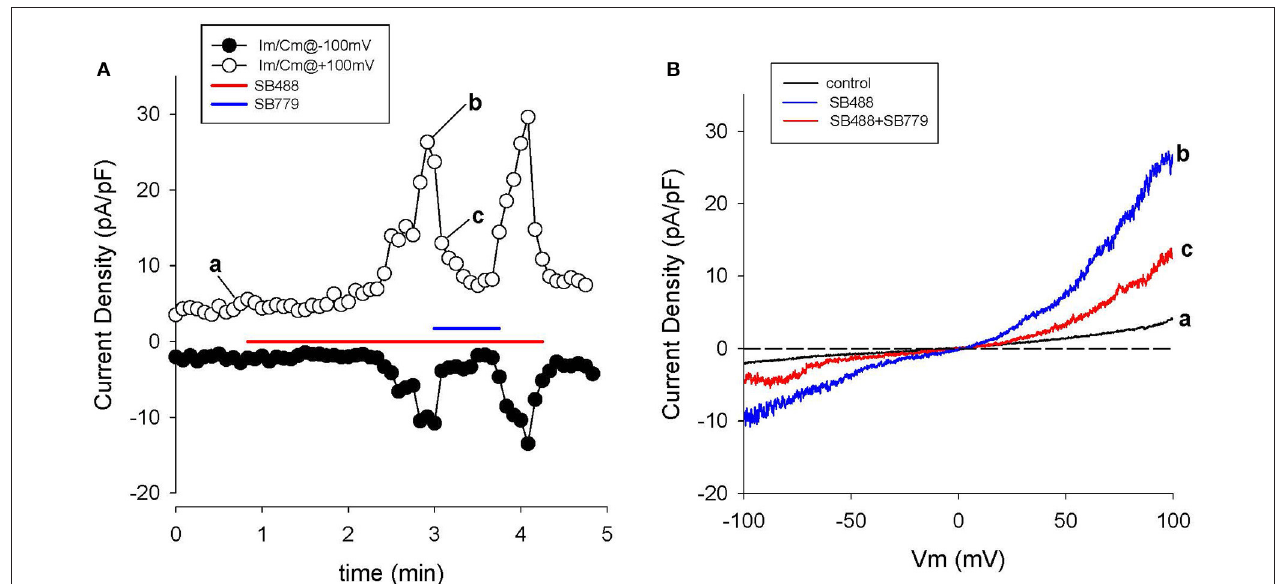
FIGURE 9 | Block of SB488-induced currents through TRPV4 channels by SB779. (A) Time course of membrane current changes at 100mV (closed circles) during repeated ramp voltage-clamp protocols. Colored bars indicate application of 1 µ M SB488 (red), or SB488 − the nearly complete inhibition of SB488-induced current by SB779. I-V relations before (a), during SB488 (b) and during SB488 superimposed I-V curves: (a) baseline, (b) in the agonist (SB488), and (c) in the combined presence of SB488 and